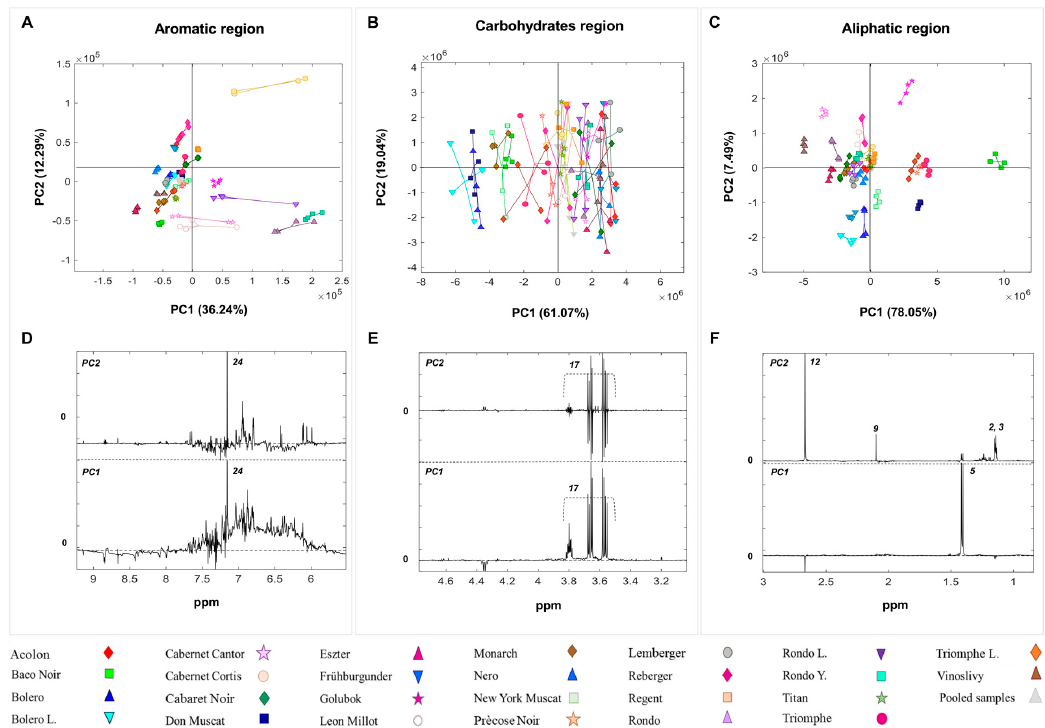
Figure 3. Scores and loadings plots of the PCA on the aliphatic (0.80–3 ppm) ( C – F ), carbohydrates (3.01–5.50 ppm) ( B – E ), and aromatic (5.51–9.30) ( A – D ) regions of the 1 H-NMR spectra from the dried wines. The explained variance for each principal component is reported in parenthesis.